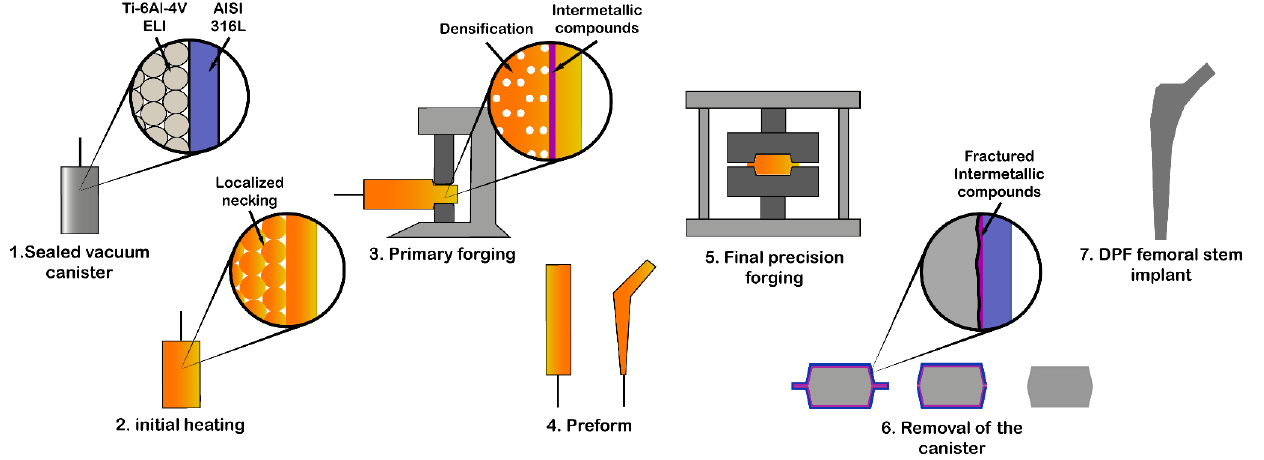
Figure 2. Schematic representation of the DPF NNS procedure used in this study to process titanium powder into femoral stem implant.